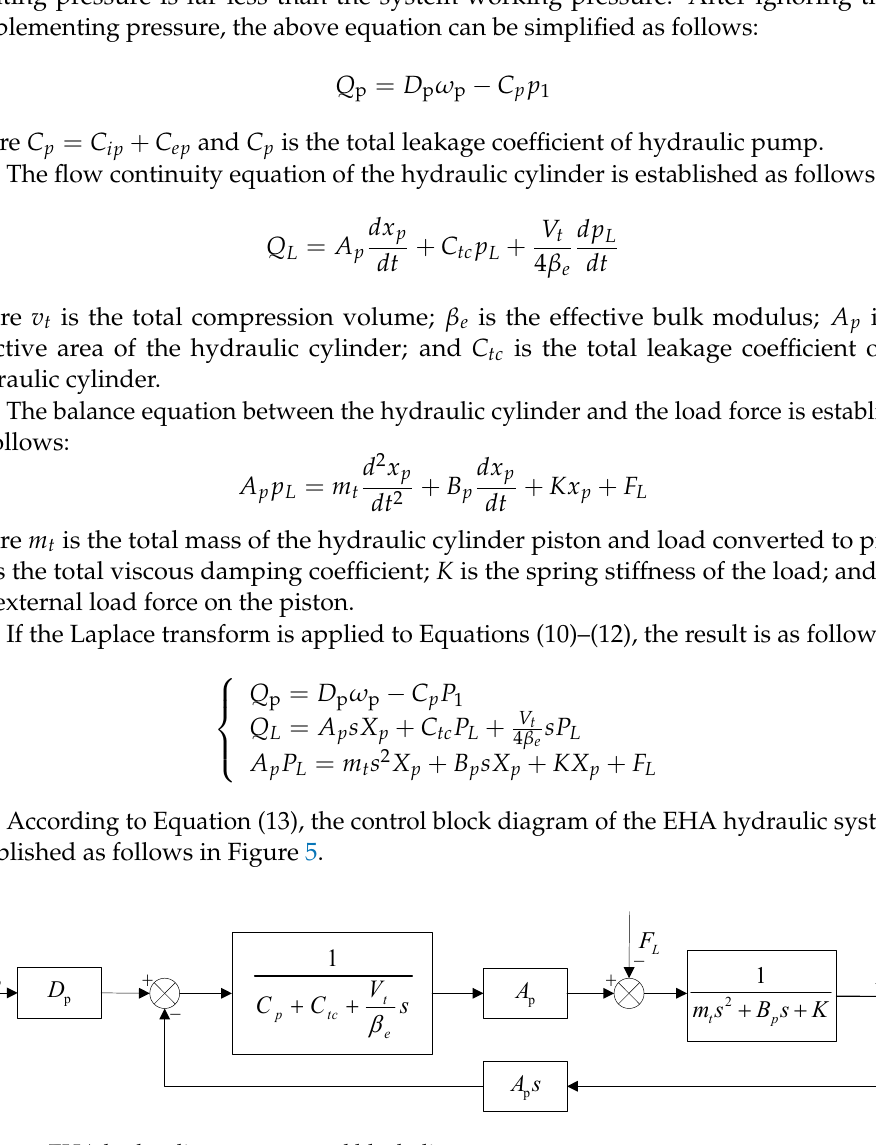
Figure 5. EHA hydraulic system control block